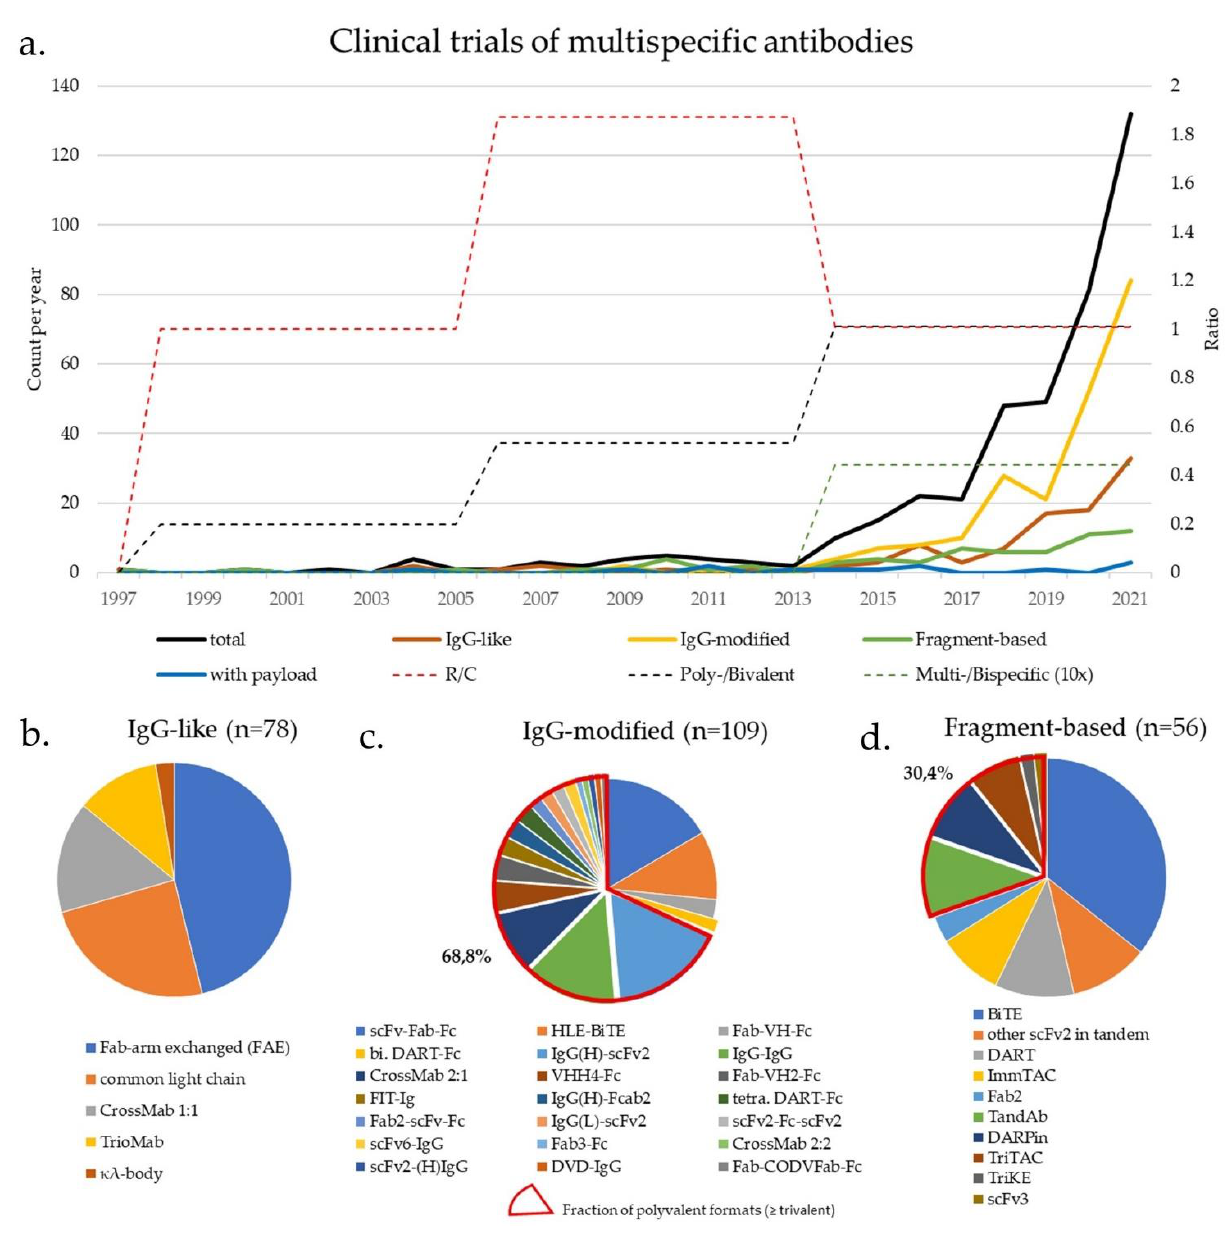
Figure 2. Landscape of clinical trials using multispecific antibodies in oncology: ( a ) Longitudinal changes in the cumulative number of initiated clinical trials since 1997 for each of the main categories according to Table 1, as well as in the ratios of constructs with “redirecting”/”classical” mode of action, and ≥trispecific/bispecific (×10), or ≥trivalent/bivalent formats in 1997–2005, 2006–2013, and 2014–2021. The search strategy is described in Section 3. For 2021, only studies until April were considered, and their number was corrected for the smaller time duration (4/12 months); ( b – d ) Distribution of clinical trials among individual formats, according to the classification in Table 1. Fab-arm-exchanged constructs dominate among IgG-like formats, IgG(H)-scFv2 or scFv-Fab-Fc, and multivalent constructs dominate among IgG-modified formats, while BiTEs dominate among fragment-based formats. The numbers are shown in Table 1, the structural details in Figure 1, while the complete list of trials is given in the Supplementary Table S1 ( n = 324, of which 309 with reported molecular formats). Fusion proteins were excluded from this analysis.